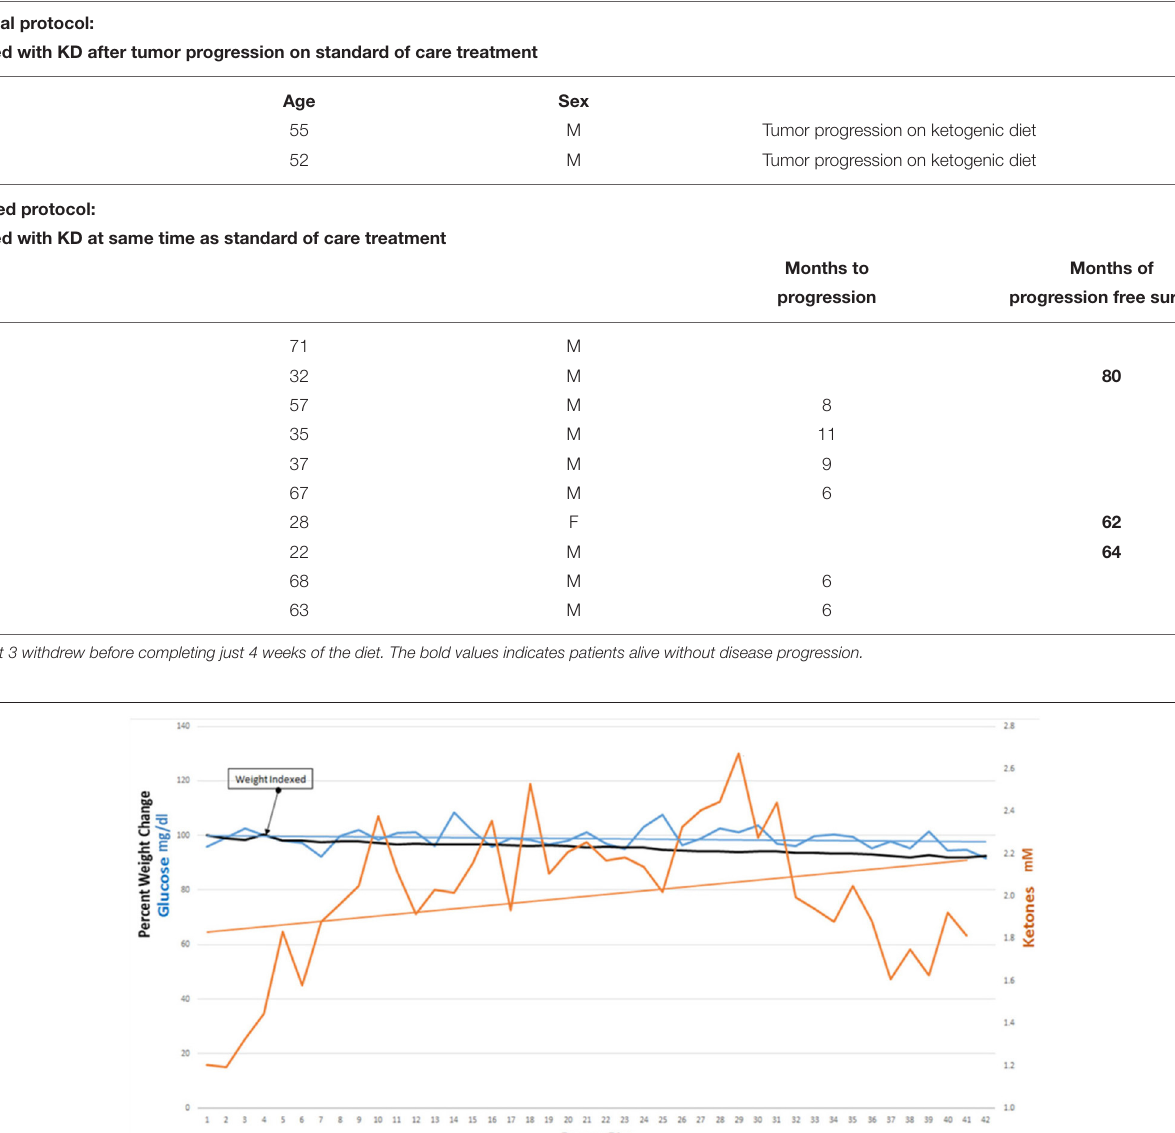
TABLE 2 | Patient outcomes.